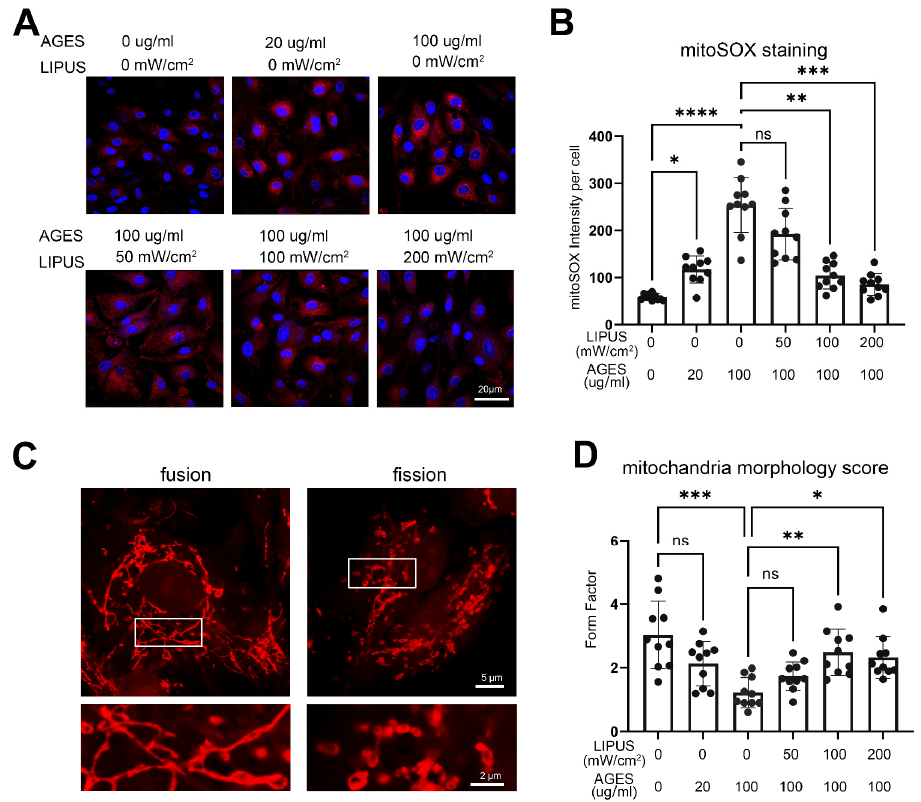
Figure 6. The effect of LIPUS treatment on CCECs mitochondria. ( A ) Immunofluorescence staining of mitoSOX (red) in CCECs after different doses of LIPUS stimulation under the AGES treatment state. The scale bar represents 20 µ m. ( B ) The statistical analysis of the mitoSOX fluorescence intensity per CCEC. n = 10 regions from 5 independent samples. Data are shown as mean ± SD. ns, not significant; *, p < 0.05; **, p < 0.01; ***, p < 0.001; ****, p < 0.0001. ( C ) Immunofluorescence staining of mitoSOX shows the two typical morphologies of CCECs before and after LIPUS treatment. The lower panels are a magnification of the upper rectangle. The scale bar represents 5 µ m (lower panel) and 2 µ m (lower panel). ( D ) The statistical analysis of the Form Factor in each CCECs group. n = 10 regions from 5 independent samples. Data are shown as mean ± SD. ns, not significant; *, p < 0.05; **, p < 0.01; ***, p < 0.001. AGES: advanced glycation end products; LIPUS: low-intensity pulsed ultrasound.